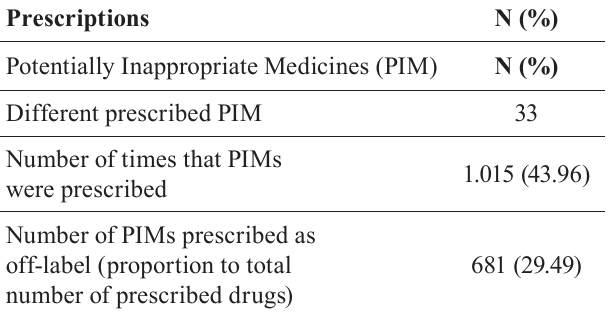
TABLE I – G eneral indicators of prescriptions, drugs and off- label drug use prevalence among the 57 patients of the study